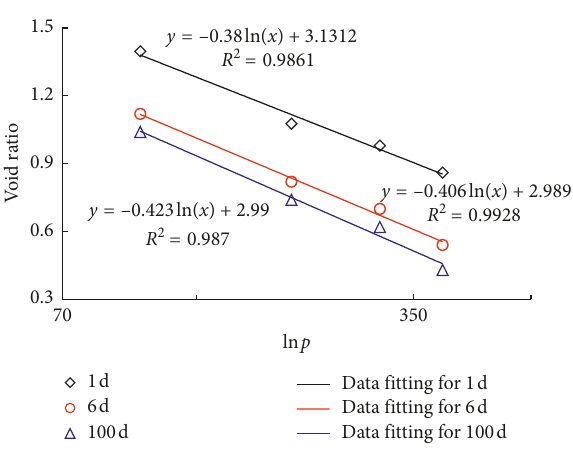
Figure 5: Relationship of void ratio and ln p .